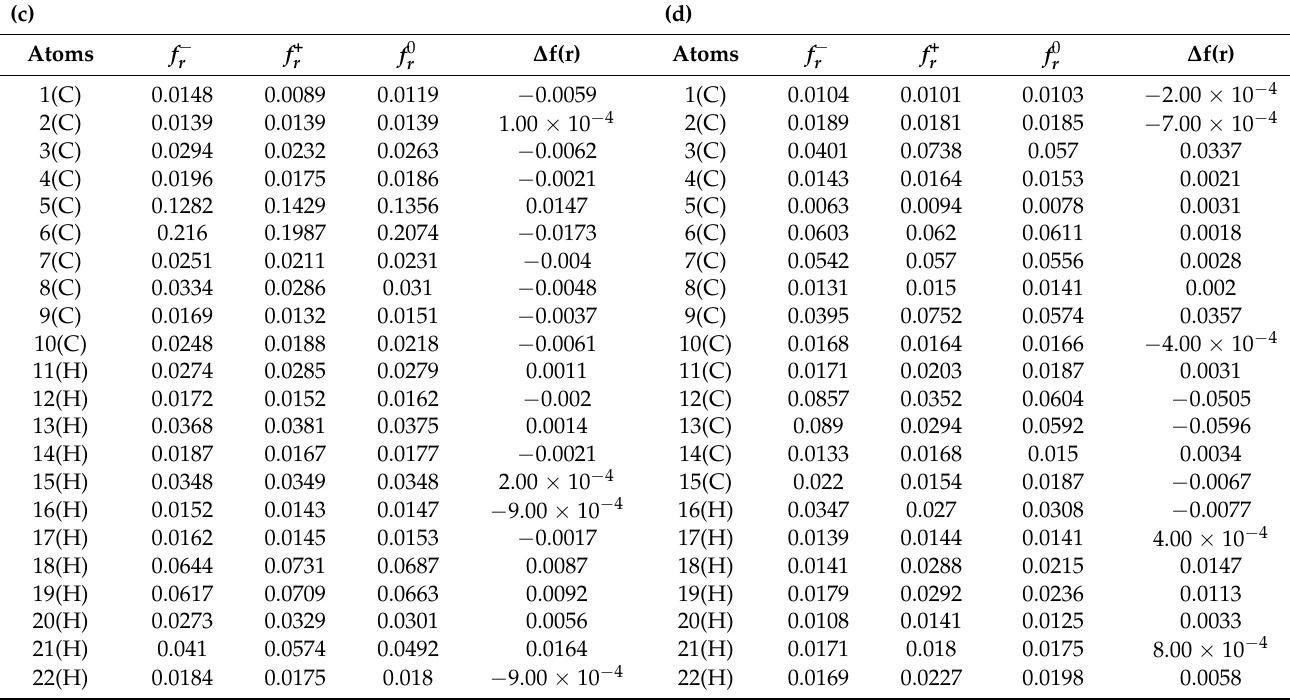
Table 5. The condensed Fukui functions for camphene (c) and α -humulene